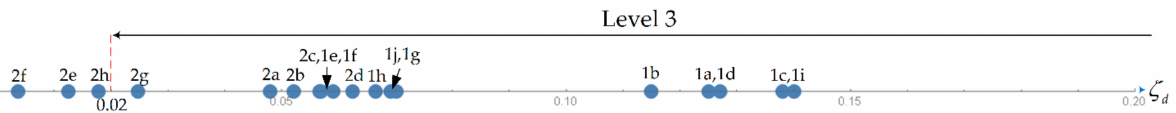
Figure 5. Handling Qualities levels for the spiral mode.